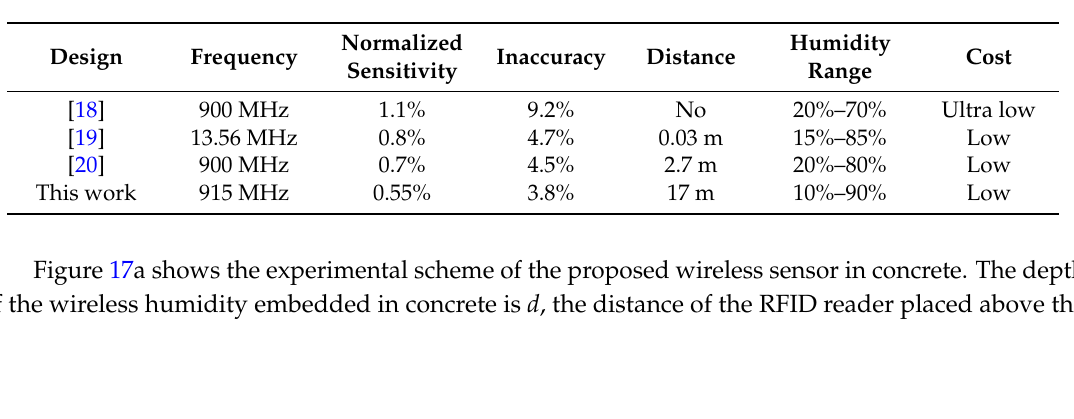
Table 2. Performances comparison of various type RFID humidity sensor.